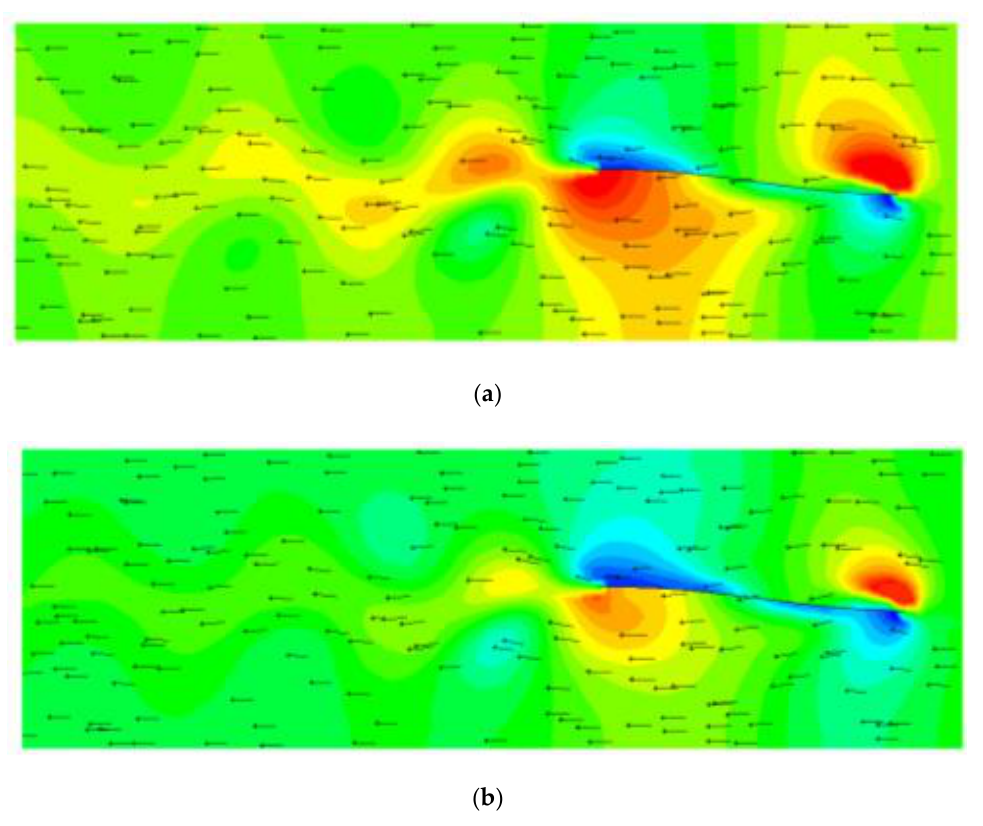
Figure 4. Velocity field overlaid with pressure field [50]; ( a ) BCF; ( b ) MPF.